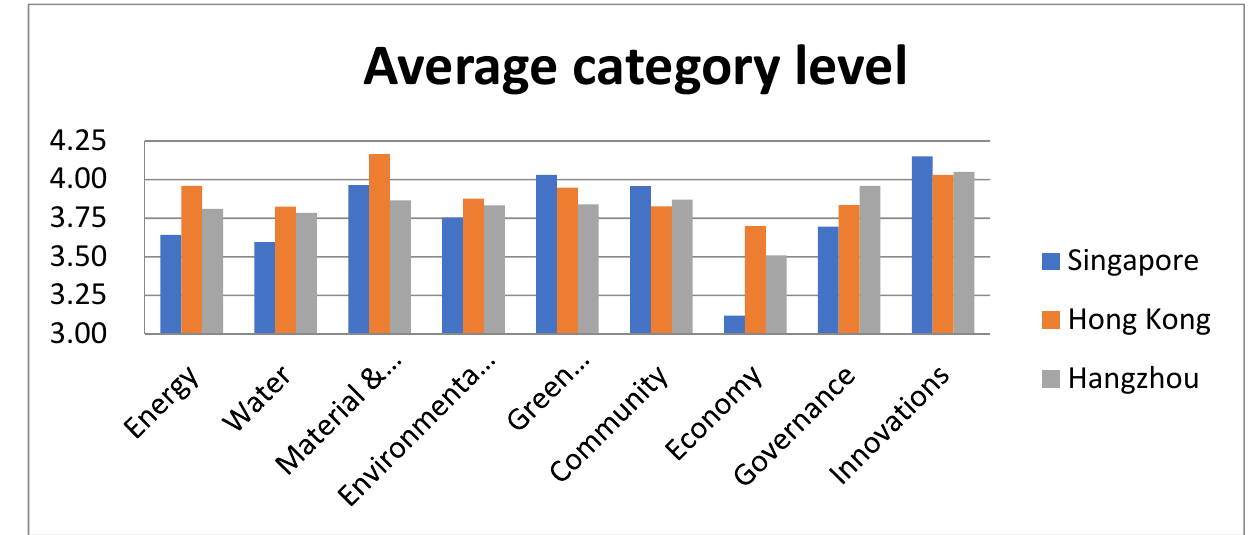
Figure 1. Importance of each category of elements of attentions for enhancing urban resilience in the three cities.